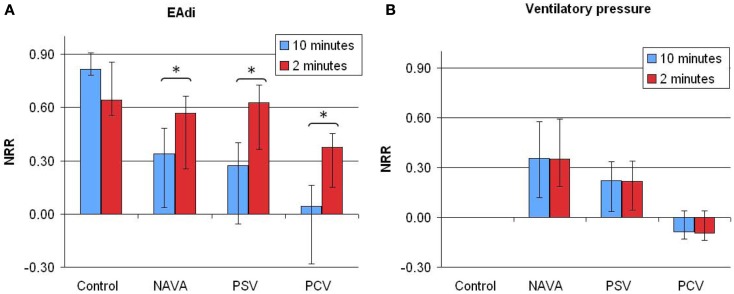
Non-rhythmic to rhythmic (NRR) index for electrical activity of the diaphragm [EAdi (A)] and ventilatory pressure (B) signals, calculated over 10 min (blue bars) or 2 min (red bars) periods in infants without ventilatory support (control) and during mechanical ventilation in neurally adjusted ventilatory assist (NAVA), pressure support ventilation (PSV), and pressure-controlled ventilation (PCV). Note that time scale of assessing variability using NRR index has an effect on estimating EAdi variability (p = 0.03), but not on estimating the ventilator pressure variability (p = 0.44). NRR, arbitrary units. Data are presented as median [25–75%]. *p < 0.01 in pairwise comparison.